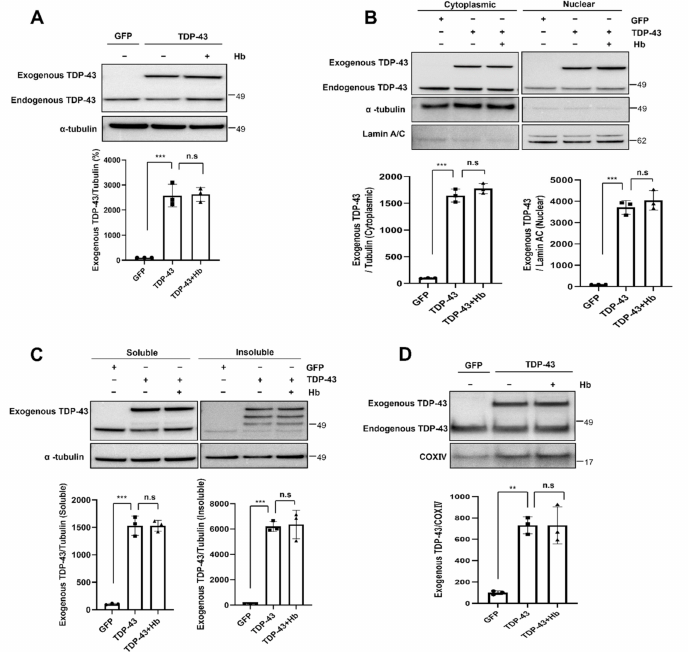
Figure 3. Hydroxocobalamin did not affect the aggregation and mislocalization of TDP-43. In the immunoblot analysis, cells were infected with the GFP- or GFP-tagged human WT TDP-43 lentivirus and grown for 2 days. The day before harvest, cells were treated with Hb (10 µ M) for 24 h. ( A ) Cell lysates were prepared, and samples were immunoblotted with anti-TDP-43 antibodies. Hb treatment did not affect the TDP-43 protein levels. ( B ) Cytoplasmic and nuclear localization of exogenous TDP-43 in neuronal cells treated with Hb. Bar diagrams showing cytoplasmic and nuclear TDP-43 levels normalized to α -tubulin or Lamin A/C, respectively, are shown. Data are presented as the means ± SD of three independent experiments. *** p < 0.001 and n.s., not significant (one-way ANOVA with Tukey’s multiple comparison test). ( C ) Immunoblot analysis of soluble and insoluble exogenous TDP-43 protein levels in TDP-43-expressing cells treated with Hb. Error bars represent the mean values ± SD of three independent experiments. *** p < 0.001 and n.s., not significant (one-way ANOVA with Tukey’s multiple comparison test). ( D ) Immunoblot analysis showing the localization of the exogenous TDP-43 protein in the mitochondrial fraction. Normalization was performed using COX IV as a marker of purified mitochondria. Data are presented as the means ± SD of three independent experiments. Statistical analyses were performed using one-way ANOVA followed by Tukey’s multiple comparison test. ** p < 0.01, *** p < 0.001, and n.s., not